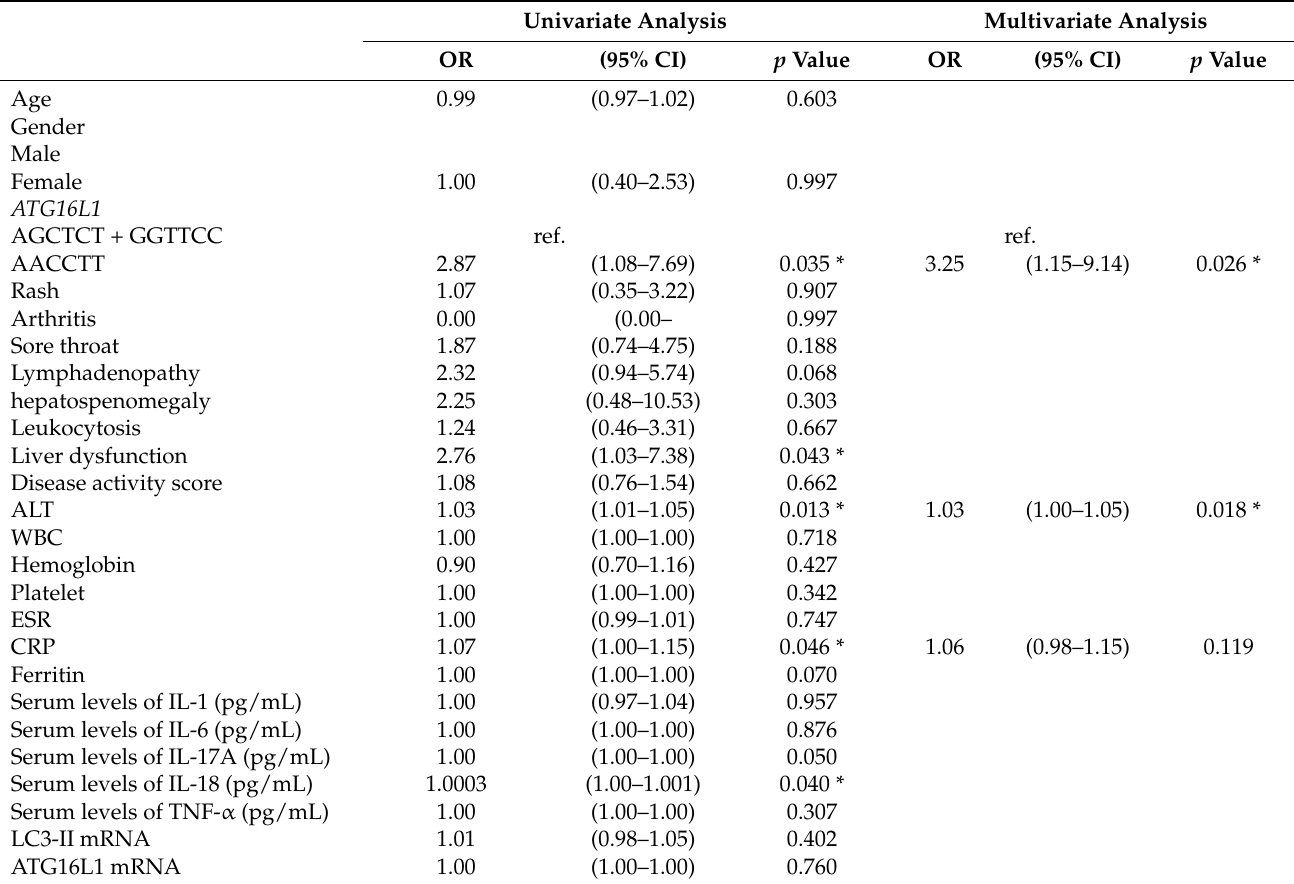
Table 4. Logistic regression analysis for the systemic pattern of adult-onset Still’s disease. Univariate Analysis Multivariate